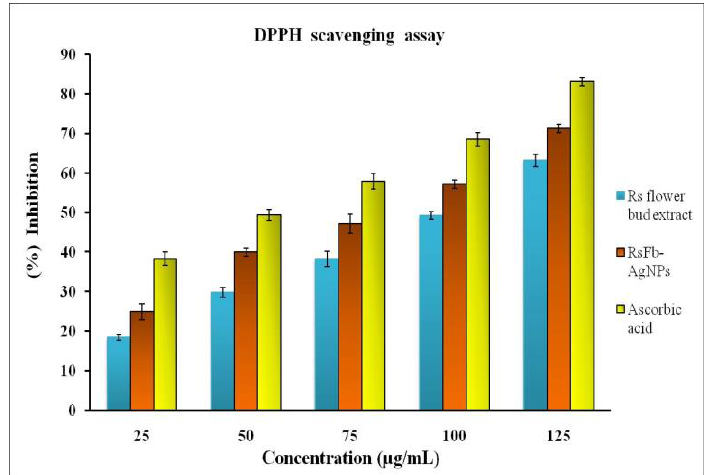
Figure 8. Antioxidant activity of flower bud extract, synthesized RsFb-AgNPs, and standard reference on DPPH radical. Table 1. MIC and MBC values of synthesized RsFb-AgNPs treated against selected bacterial strains. Bacterial Strains